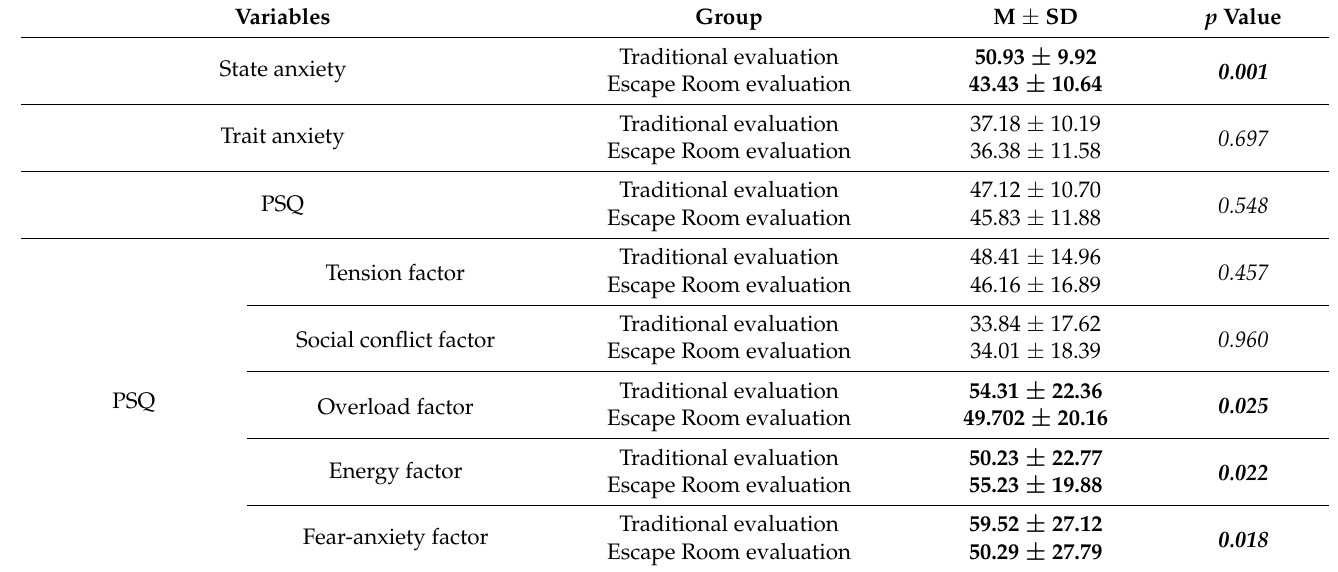
Table 1. Comparison between traditional and the Escape Room assessment.